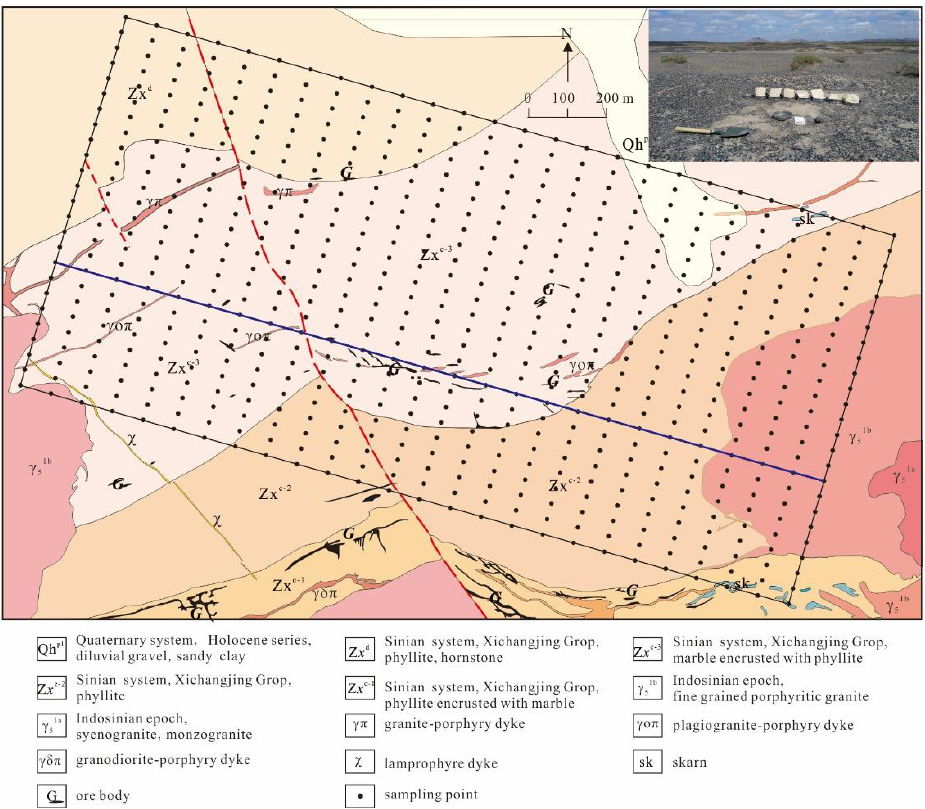
Figure 2. Geological sketch map (modified after Liu et al. [27]) and sampling sites of the Huaniushan Pb-Zn deposit.